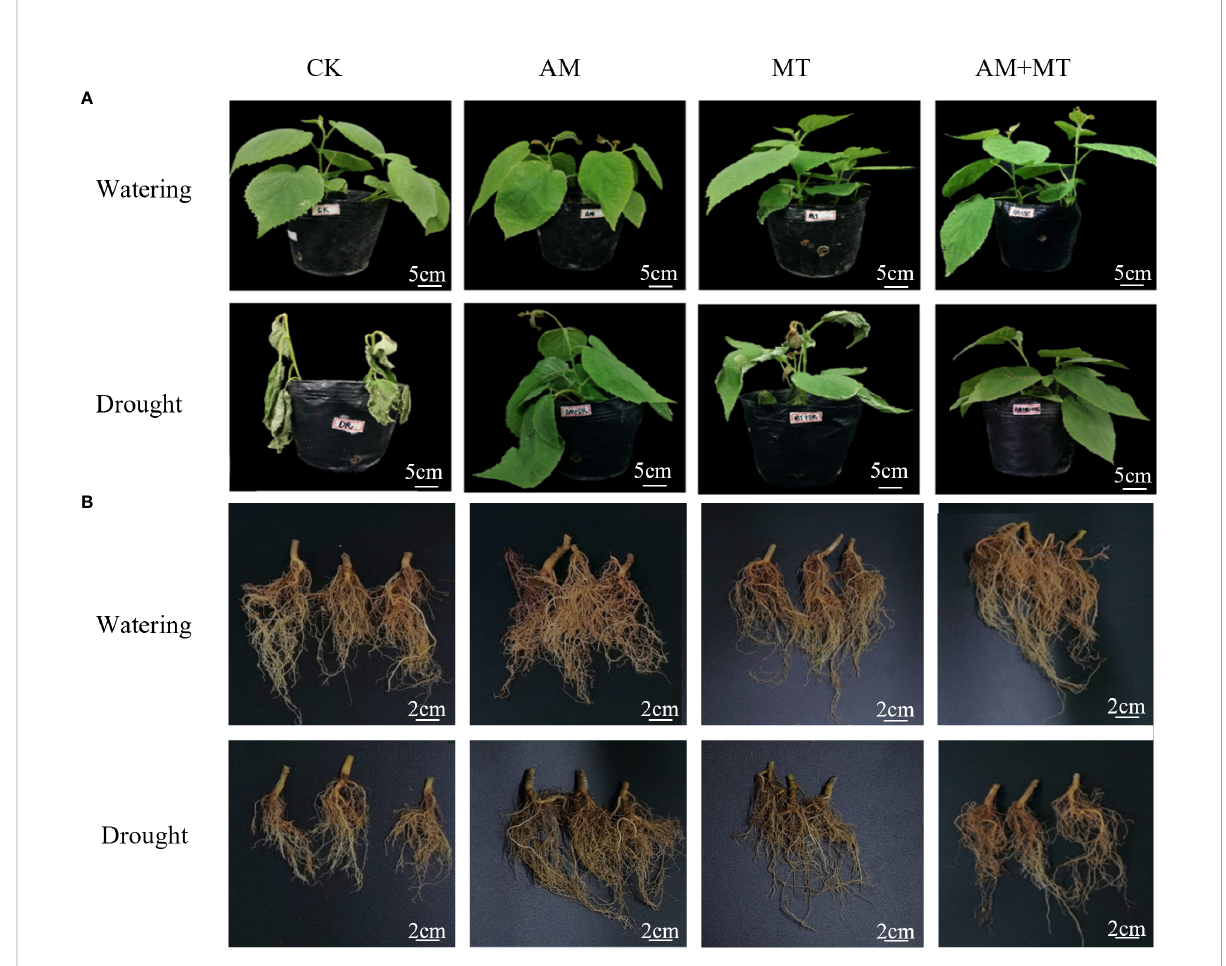
FIGURE 2 Effect of treatment on plant growth of above-ground (A) and under-ground (B) parts under well watering and drought condition. Treatments included CK (the control), AM (inoculated with arbuscular mycorrhiza), MT (irrigated with 100 m M melatonin), and AM+MT (treated with melatonin and arbuscular